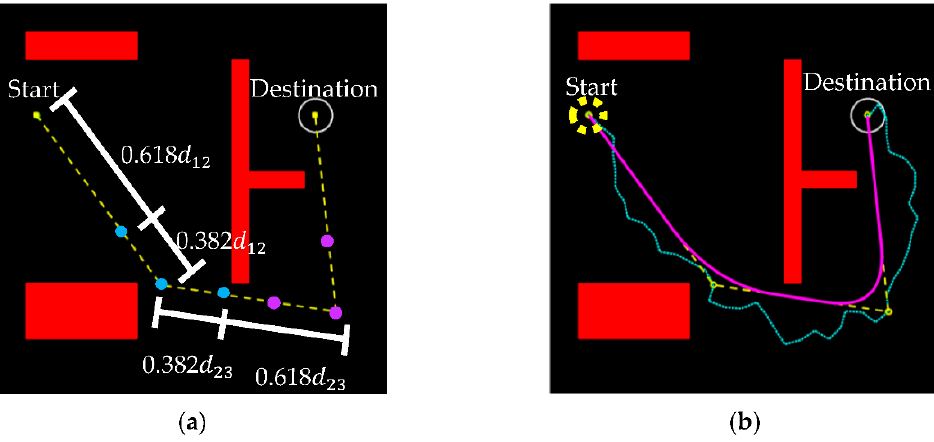
Figure 4. ( a ) Illustration of using two control points for smoothing each turning point in the path by a Bézier curve and ( b ) comparison of the paths predicted by the RRT algorithm (the zigzag) and by the improved RRT algorithm with the pruning and smoothing (the smooth) of this work.